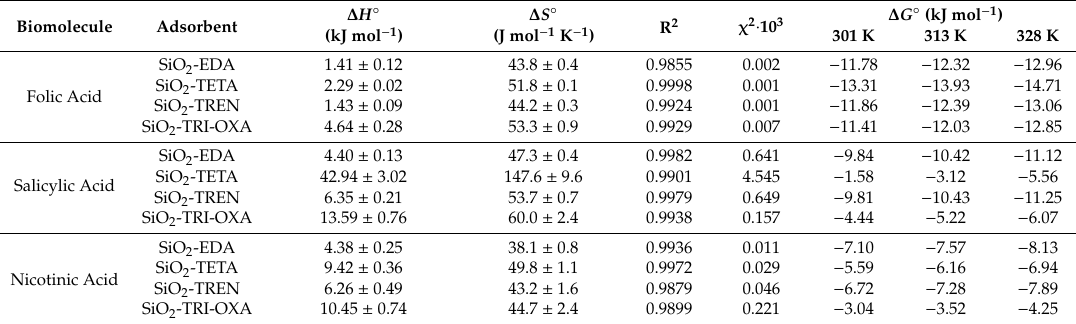
Thermodynamic parameters of the biomolecules’ adsorption processes on the dendrimer-grafted silica-supported